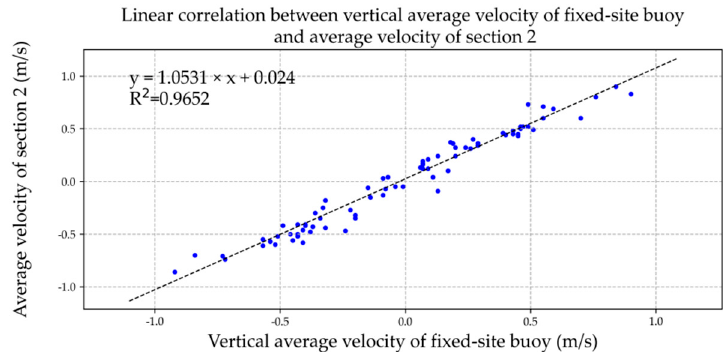
Figure 12. Linear correlation between vertical average current of fixed-site buoy and average velocity of section 2. The data of blue dots represent the relationship between vertical average velocity of the fixed ‐ site buoy(x) and average velocity of section 2(y).